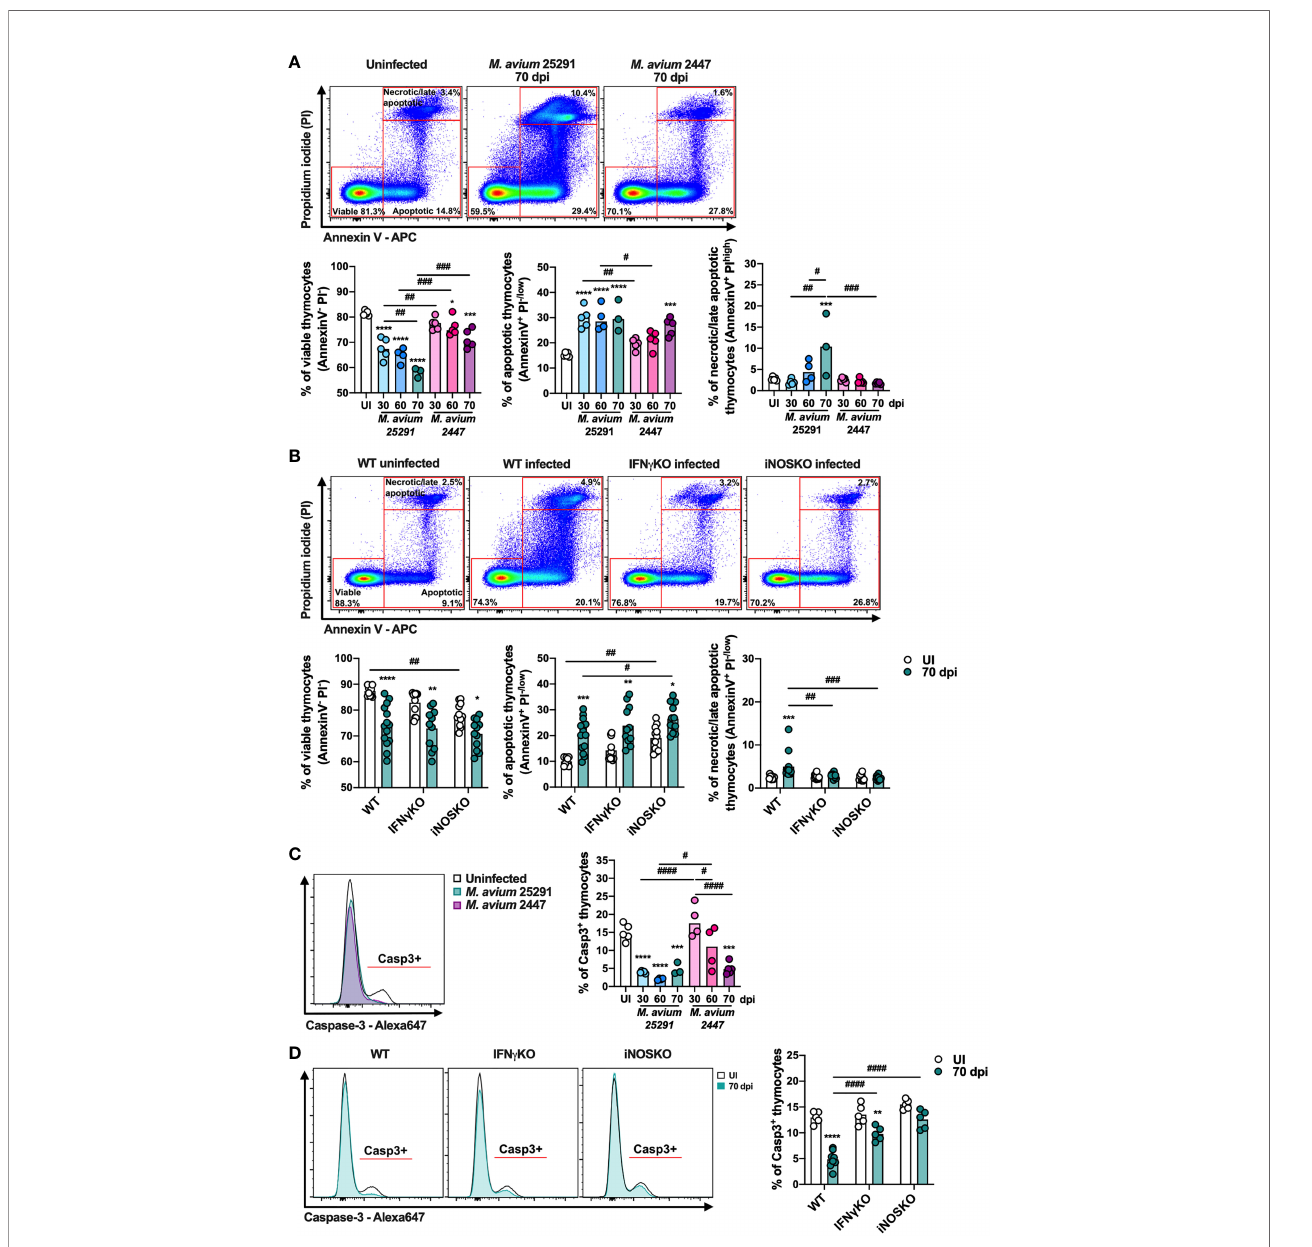
FIGURE 7 | The percentage of viable cells and of cells positive for active caspase-3 decrease after infection. (A) Representation of the gating (top) and plotting of viable (left graph – AnnexinV - PI - ), apoptotic (center graph – AnnexinV + PI -/low ) and necrotic/late apoptotic (right graph – AnnexinV + PI high ) thymocytes from uninfected WT mice (white) or infected for 30, 60 or 70 days with M. avium 25291 (blue) or M. avium 2447 (pink). (B) Representation of the gating (top) and plotting of viable (left graph – AnnexinV - PI - ), apoptotic (center graph – AnnexinV + PI -/low ) and necrotic/late apoptotic (right graph – AnnexinV + PI high ) thymocytes from WT, IFN g KO or iNOSKO mice uninfected (white) or infected for 70 days with M. avium 25291 (teal). (C) Representative histogram and plotting of active caspase-3 positive thymocytes from uninfected WT mice (white) or infected for 30, 60 or 70 days with M. avium 25291 (blue) or M. avium 2447 (pink). (D) Representative histogram and plotting of caspase-3 positive thymocytes from WT, IFN g KO or iNOSKO mice uninfected (white) or infected for 70 days with M. avium 25291 (teal). For all the analysis, total thymocytes were previously selected eliminating doublets and debris. Bars represent the mean from: 3 to 5 mice per group from one experiment for (A, C) ; 9 to 14 mice per group from two pooled independent experiments for (B, D) . In (A, C) comparisons between infected and uninfected mice were evaluated by ordinary one-way ANOVA followed by Dunnett ’ s multiple comparisons test and marked as: * p < 0.05, *** p < 0.001, **** p < 0.0001; and comparisons between infected groups were evaluated by 2-way ANOVA followed by Tukey ’ s multiple comparisons test and marked as: # p < 0.05, ## p < 0.01, ### p < 0.001, #### p < 0.0001. In (B, D) , comparisons were performed by 2-way ANOVA followed by Tukey ’ s multiple comparisons test, and marked as * p < 0.05, ** p < 0.01, *** p < 0.001, **** p < 0.0001 for differences between uninfected and infected, and as # p < 0.05, ## p < 0.01, ### p < 0.001, #### p < 0.0001 for differences between infected groups. UI stands for uninfected. Casp3 stands for active caspase-3. dpi stands for days post